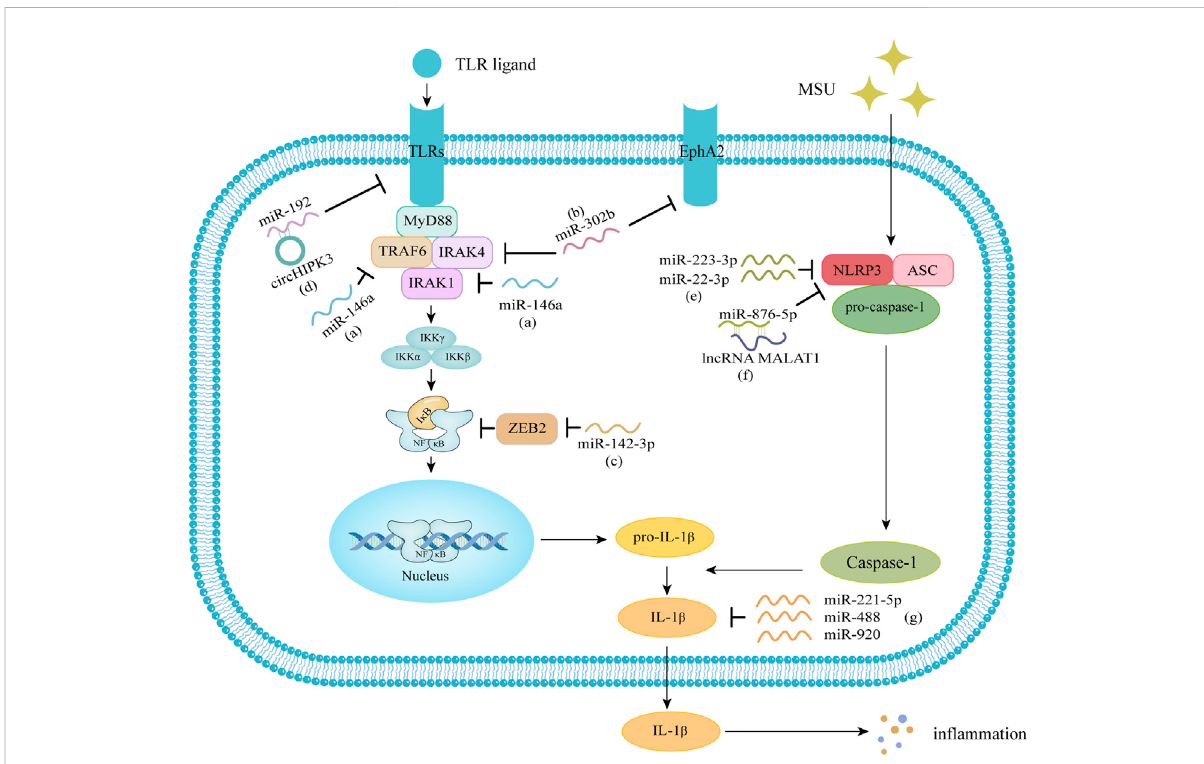
FIGURE 1 Molecular mechanisms of miRNA in gout. (A) miR-146a downregulates the levels of IL-1 β , IL-6, TNF- α , and the NLRP3 in fl ammasome through the TLR/NF- κ B signaling pathway. (B) miR-302b can negatively regulate the transcription and maturation of IL-1 β by targeting IRAK4 and EphA2. (C) miR-142-3pcantargetandnegativelyregulateZEB2,regulateNF- κ Bsignaling,andleadtoincreasedexpressionofIL-1 β ,IL-6,andTNF- α . (D) circular RNA circHIPK3 can act as a molecular sponge to bind miR-192, regulate the expression of TLR4. (E) miR-223-3p and miR-22-3p can directly inhibit the expression of NLRP3 to reduce the release of IL-1 β . (F) lncRNA MALAT1 can reduce the in fl ammatory response through the miR-876-5p/ NLRP3 pathway. (G) miR-221-5p,miR-488and miR-920can interactwith the3 ′ UTRof IL-1 β and can target and inhibit IL-1 β . MiRNA,microRNA; IL- 1 β , interleukin-1 β ; IL-6, interleukin-6; TNF- α , tumor necrosis factor- α ; NLRP3, NOD-like receptor family, pyrin domain-containing 3; TLR, Toll-like receptor; NF- κ B, nuclear factor- κ B; IRAK4, IL-1 receptor-associated kinase 4; EphA2: Ephrin type-A receptor 2; ZEB2, zinc fi nger E-box